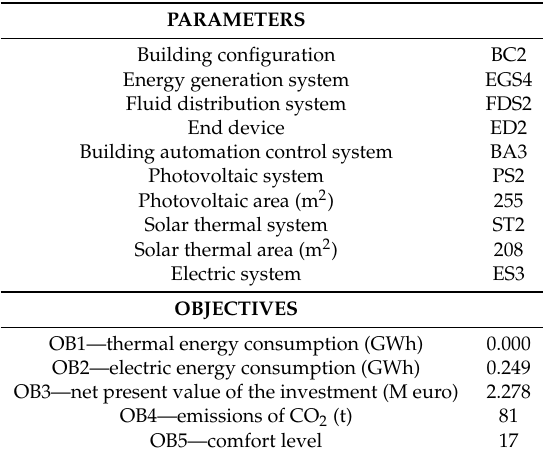
Figure 2. Strategy selection from Pareto front. ( a ) five objective representation; ( b – d ) views of figure ( a ). Parameters and objectives of the selected strategy are described in Table 2. Table 2. Selected strategy: parameters and